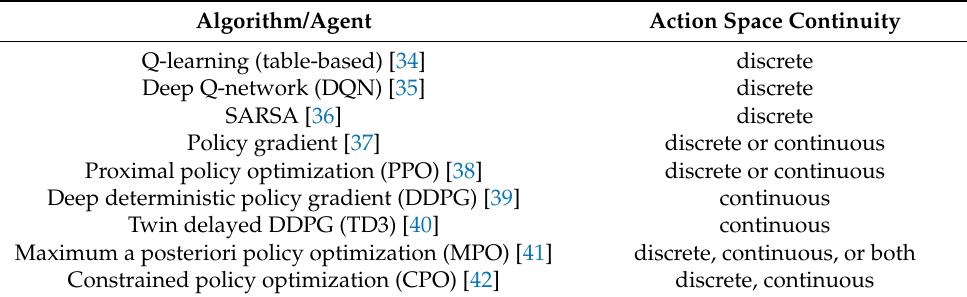
Table 1. Action space domains of selected RL algorithms † .